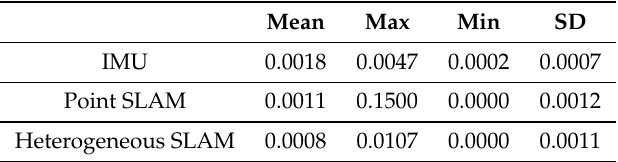
Figure 17. Robot position estimation error comparison between IMU, point SLAM and heterogeneous SLAM approaches. Table 3. Robot position error mean, maximum, minimum and standard deviation, for IMU estimation, point and heterogeneous SLAM solutions in the real